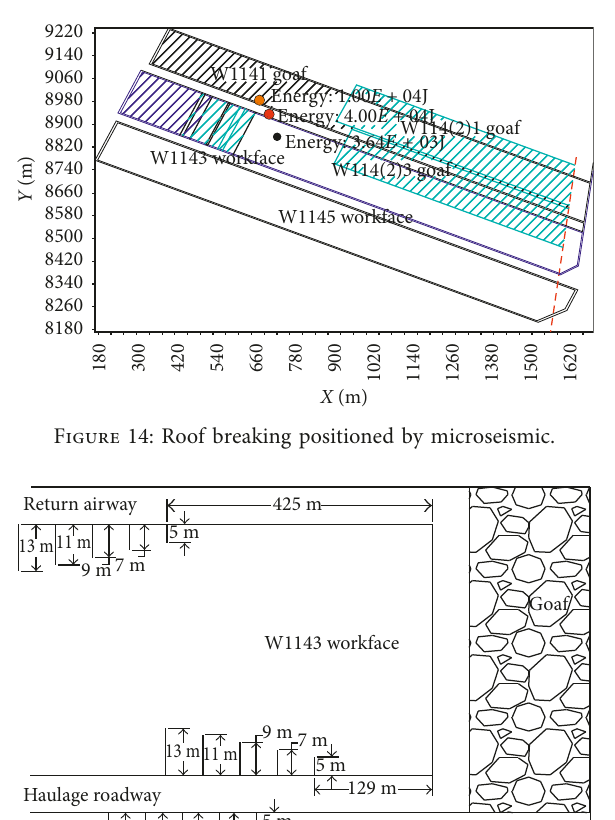
Figure 13: Coal mining face failure caused by rockburst.